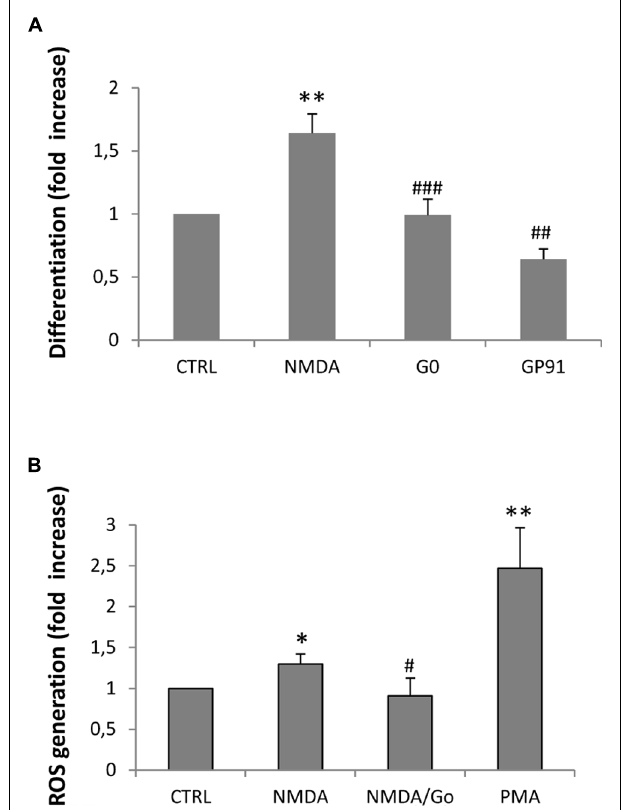
FIGURE 4 | (A) Neurospheres were differentiated to oligodendrocyte for 3–5 days in the presence of 100 μ M NMDA, 100 nM G0 6983, or 1mM gp91. Cells were fixed, immunostained with anti-MBP and counterstained with DAPI. Differentiation was calculated as a ratio between MBP positive cells vs. total cells counterstained with DAPI and expressed as a fold increase respect to the control. Counts represent means ± SEM ( n = 4 independent experiments, five fields in each). ∗∗ p < 0.01 vs. CTRL, ### p < 0.001 and ## p < 0.01 vs. 1 μ M NMDA (B) ROS generation was calculated by luminescence after 3 days of differentiation in the presence of 100 μ M NMDA and the PKC inhibitor G0 6983.The PKC activator PMA was used as a control for PKC-dependent ROS generation. Counts represent means ± SEM ( n = 4 independent experiments, five fields in each). ∗ p < 0.05 and ∗∗ p < 0.01 vs. CTRL, # p < 0.05 vs. 1 μ M